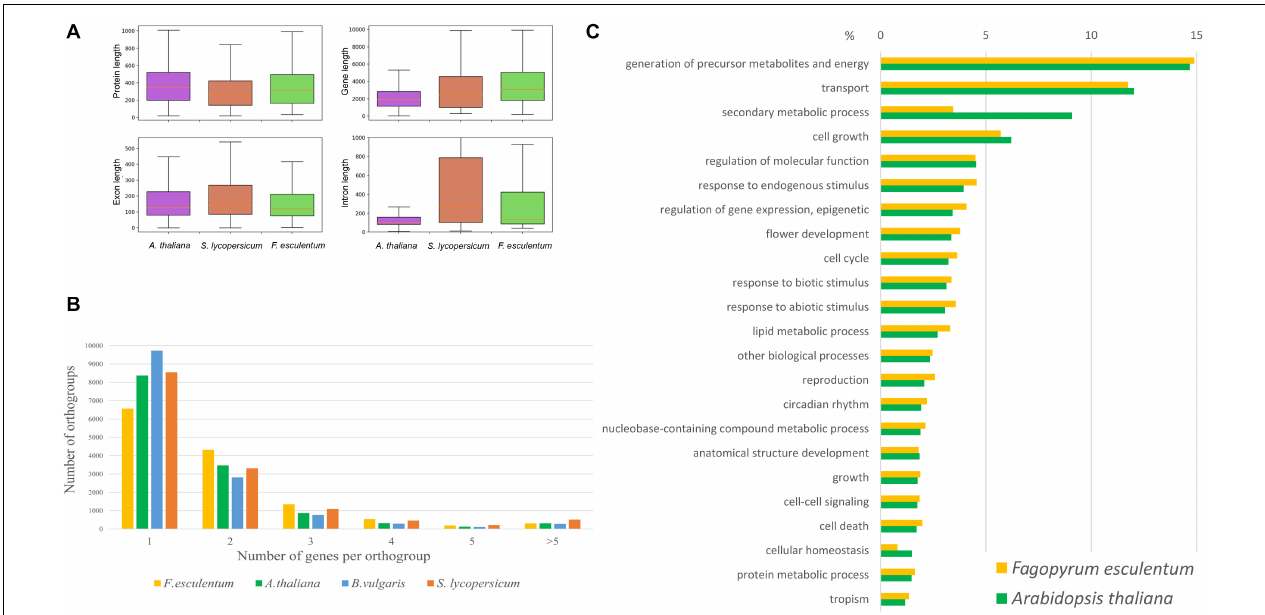
FIGURE 1 | (À) Annotation of F. esculentum compared with those of A. thaliana and S. lycopersicum in terms of the gene, exon, and intron length distribution. (B) The number of genes per orthogroup in Fagopyrum esculentum , Beta vulgaris , Solanum lycopersicum , and Arabidopsis thaliana. (C) The distribution of GO categories (biological function) in Fagopyrum esculentum and Arabidopsis